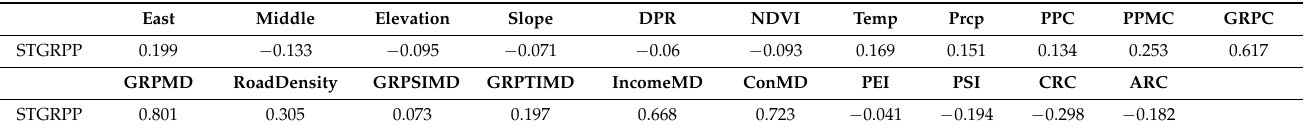
Table 2. Correlation coefficient values between STGRPP and the independent variables for all 294 cities (see Table 1 for